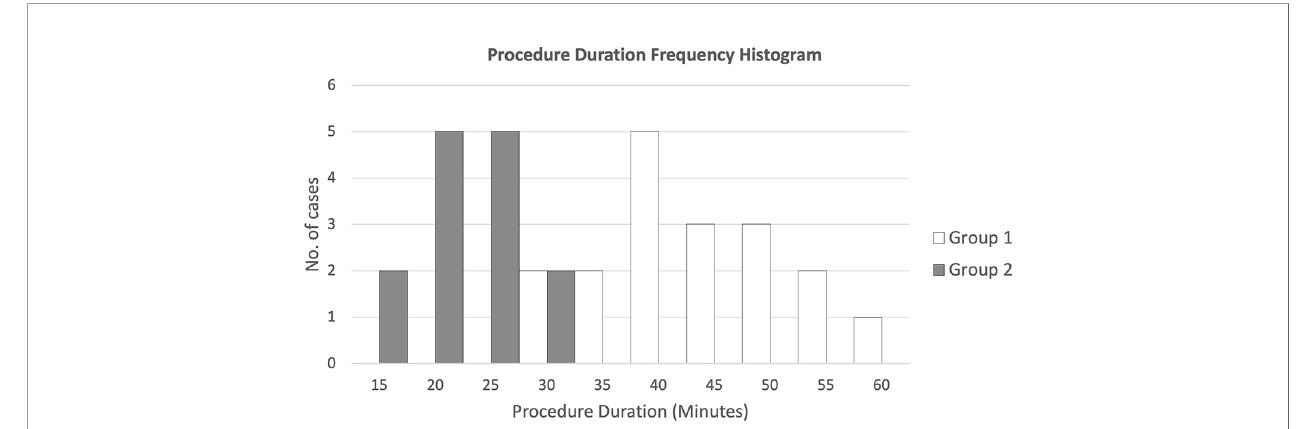
DAP, dose area product.